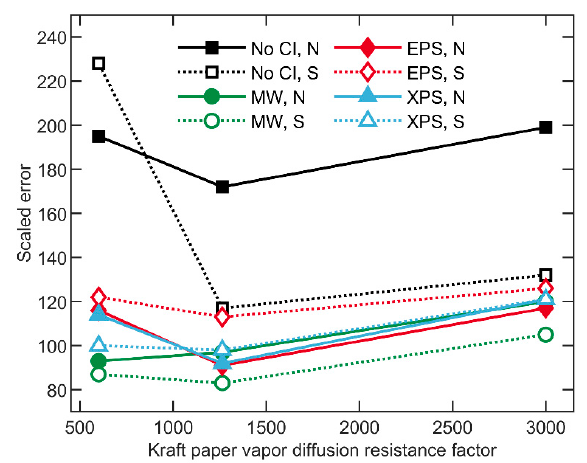
Figure 23. Scaled error for kraft paper vapor diffusion resistance factor values.